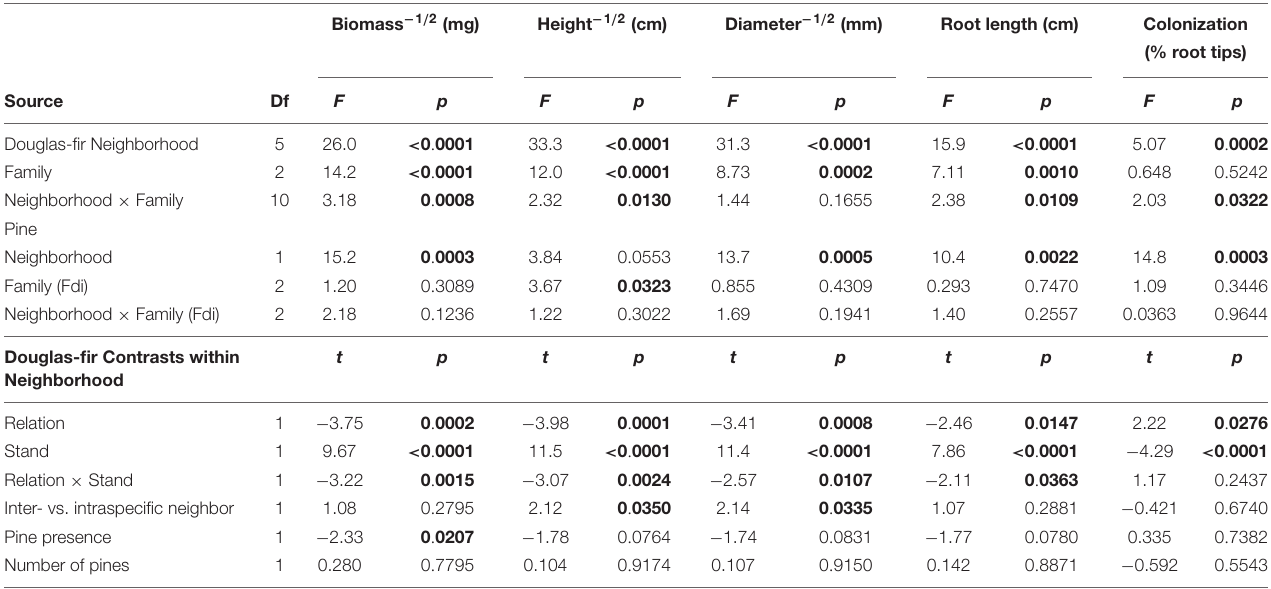
TABLE 1 | Analyses of variance for size measures and mycorrhizal colonization for greenhouse-grown interior Douglas-fir